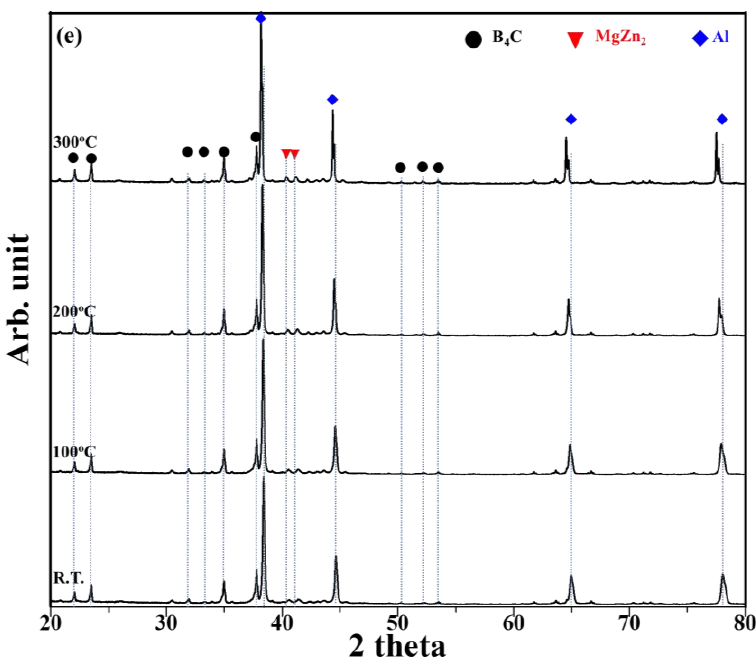
Figure 4. In situ high temperature-x-ray di ff ractometer (HT-XRD) results of the AMCs at elevated temperature.